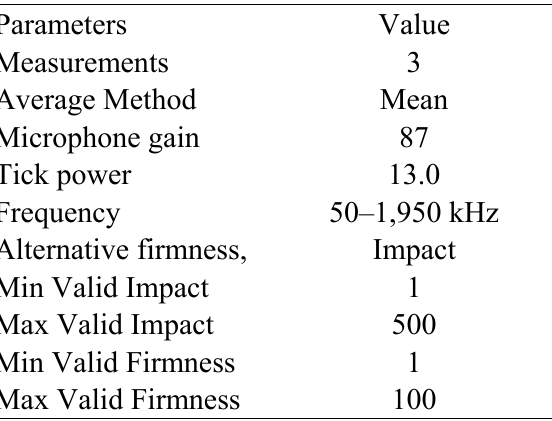
Table 3. Optimal setting configuration for